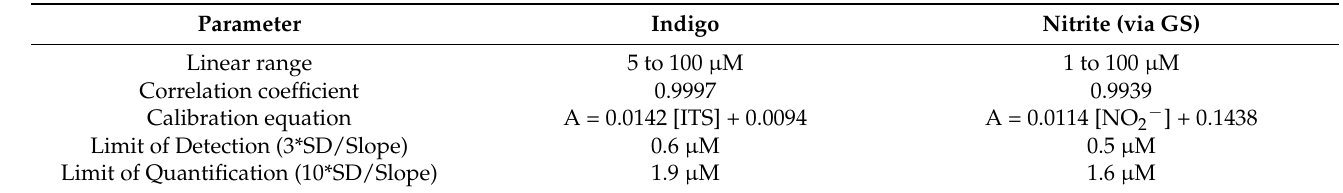
Table 1. Analytical performance obtained for the indigo and nitrite determinations using the portable Arduino-based